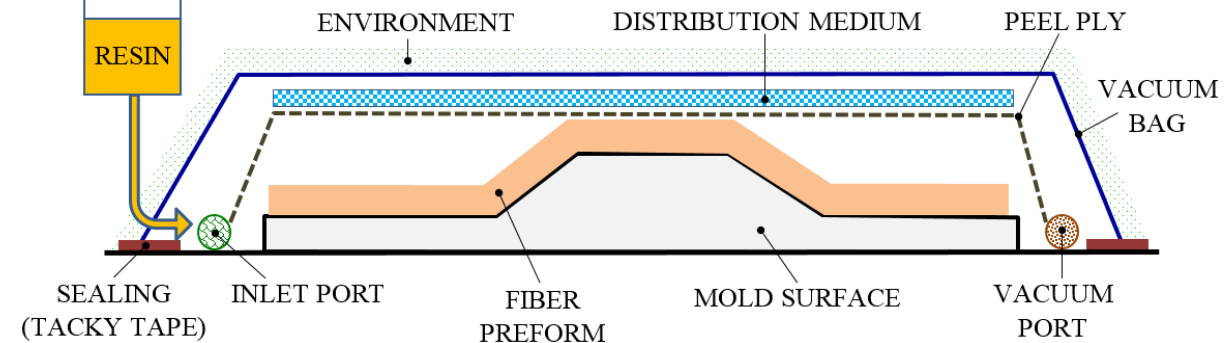
Figure 9. Line diagram for vacuum ‐ assisted resin transfer molding process setup.